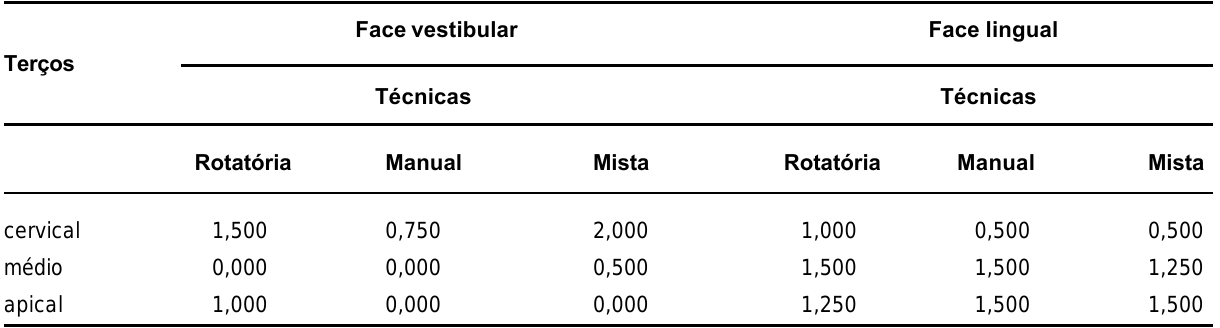
TABELA 2- Avaliação da limpeza do canal radicular em relação às técnicas estudadas, nos três terços